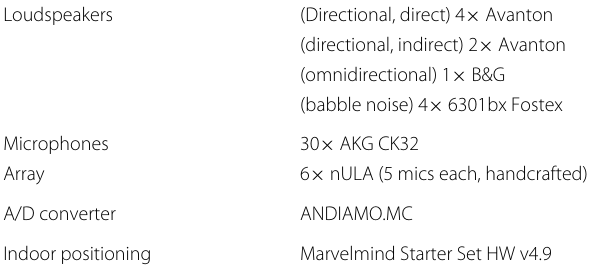
in and out over 0.2 s with a Tuckey taper window. 3 Second, 10-s bursts of white noise were played in the room. Finally, for each recording, 3 different anechoic speech utterances from the Wall Street Journal (WSJ) dataset [44] were used